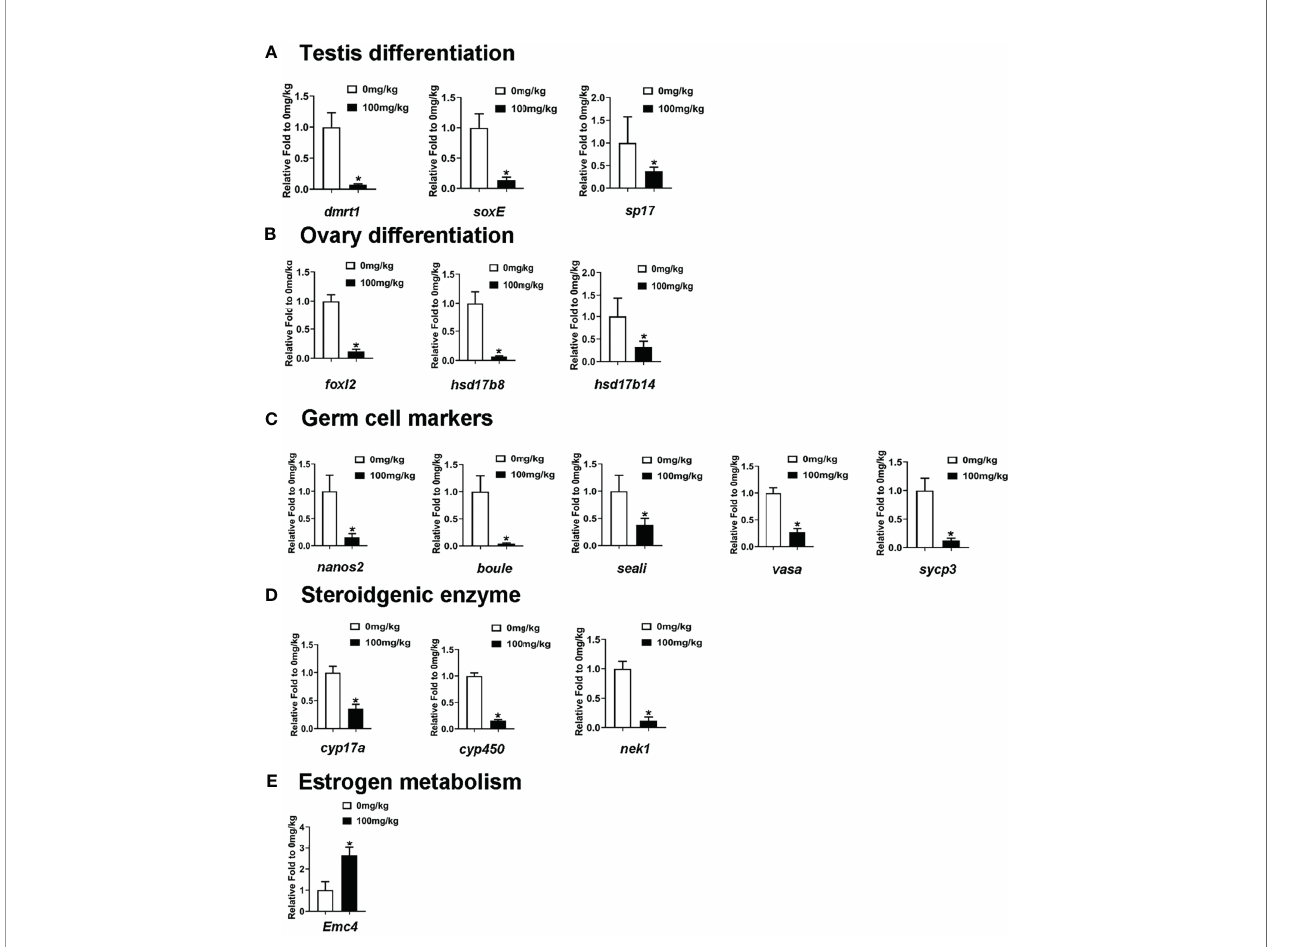
FIGURE 7 | RT-qPCR measured the mRNA levels of sex-related genes and estrogen metabolism-related genes in the testis of E2-treated S. intermedius . (A) The expression of testis differentiation genes. (B) The expression of ovary differentiation genes. (C) The expression of germ cell marker gene. (D) The expression of steroidgenic enzyme gene. (E) The expression of estrogen metabolism gene (Emc4). 18S was used as the control. Each bar represents mean ± standard deviation (SD) ( n = 3). One-way ANOVA was used to determine statistical analysis. Asterisks (*) indicate signi fi cant differences ( p ≤